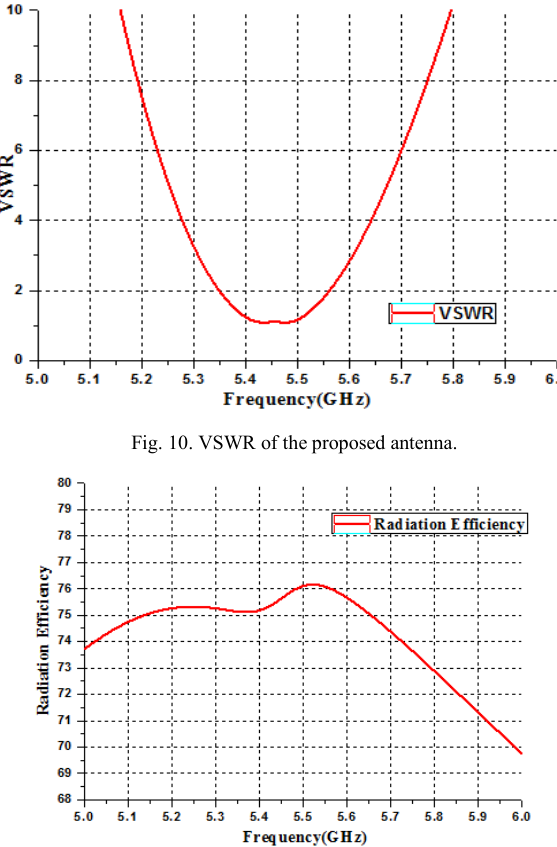
Fig. 11. The radiation efficiency of the proposed antenna.